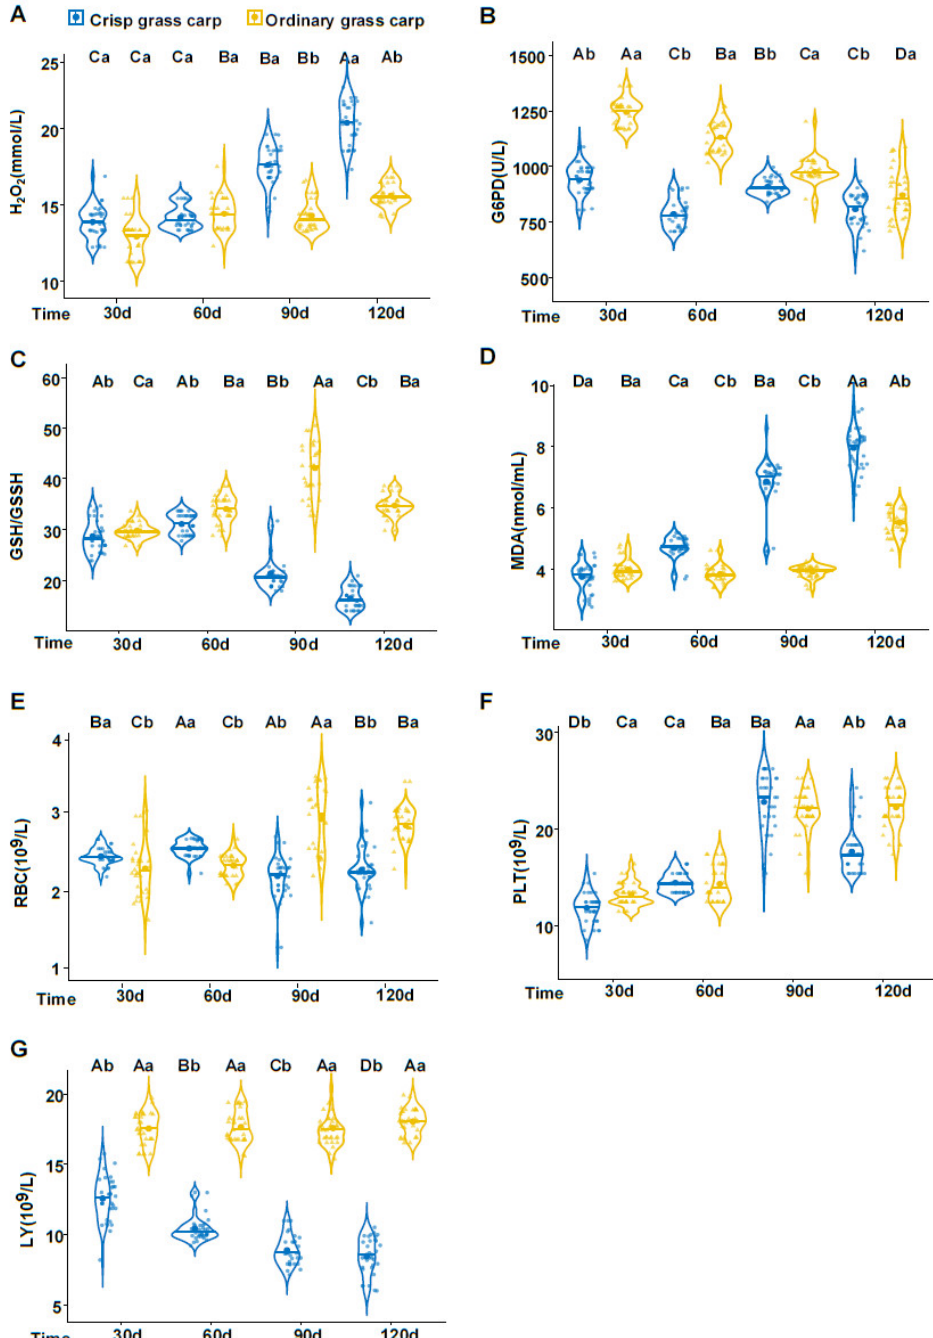
Figure 2. Violin plots of seven blood indexes in ordinary and crisp grass carp samples. The medians are represented by a horizontal blue or yellow line. The whiskers span the entire range. ( A ) H 2 O 2 . ( B ) G6PD. ( C ) GSH / GSSH. ( D ) MDA. ( E ) RBC. ( F ) PLT. ( G ) LY. Statistical analyses were performed using Student’s t -test and Duncan’s test. Di ff erent lowercase letters represent significant di ff erences in blood indexes. Di ff erent uppercase letters represent significant di ff erences in blood indexes ( p < 0.05).